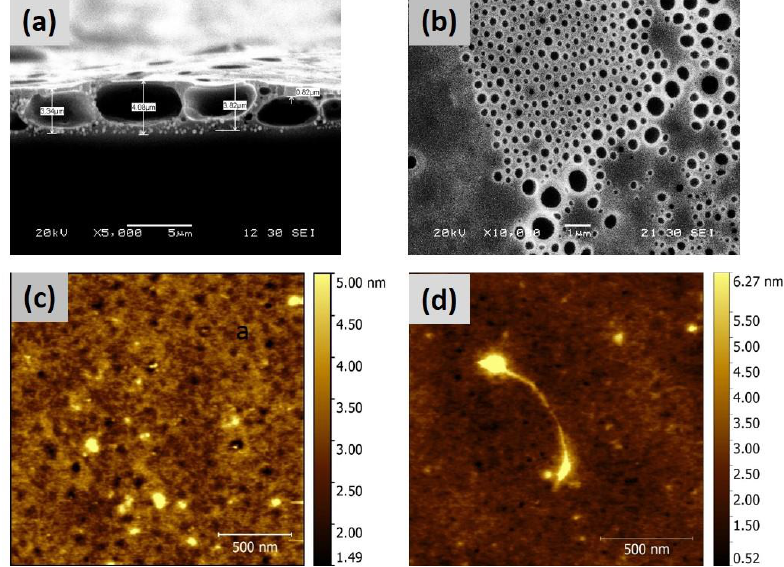
Figure 3. ( a ) SEM image of the nanocomposite transducing film’s cross section; ( b ) SEM image of transducers’ surface; ( c ) AFM image of PMMA-co-POSS copolymer; and ( d ) AFM image of nanocomposite showing CNT in the copolymer matrix.